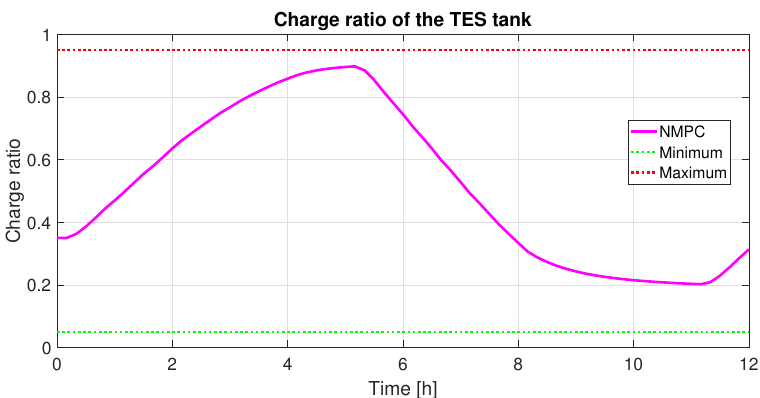
Figure 14. Charge ratio of the TES tank for the proposed scheduling strategy.